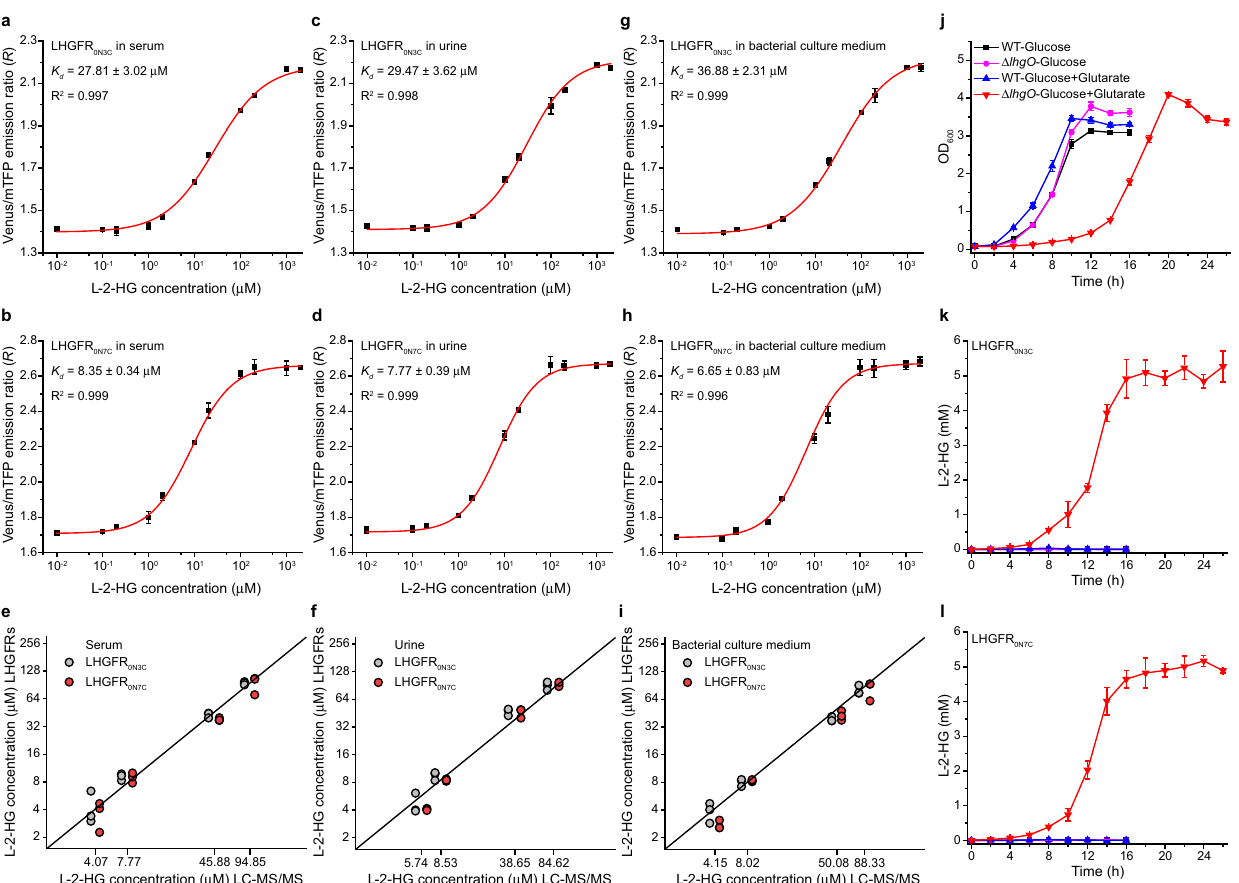
Fig. 4 Validation of puri fi ed LHGFR for determination L -2-HG levels in body fl uids and bacterial culture system. a – d Dose-response curves of puri fi ed LHGFR 0N3C and LHGFR 0N7C for increasing concentrations (10 nM to 2 mM) of L -2-HG in serum ( a, b ) and urine ( c , d ). e , f Comparison between the quantitative results of L -2-HG added in serum ( e ) and urine ( f ) by LC-MS/MS and LHGFR. The gray circles and red circles represent the quantitative results of LHGFR 0N3C and LHGFR 0N7C , respectively. Black line indicates a reference line. g, h Dose-response curves of puri fi ed LHGFR 0N3C ( g ) and LHGFR 0N7C ( h ) for increasing concentrations (10 nM to 2 mM) of L -2-HG in bacterial culture medium. i Comparison between the quantitative results of L - 2-HG in bacterial culture medium by LC-MS/MS and LHGFR. j Growth of P. putida KT2440 and its lhgO mutant in medium containing 20 mM glucose and 5 mM glutarate as the carbon sources. k , l Determination of extracellular L -2-HG accumulation of P. putida KT2440 and its lhgO mutant by puri fi ed LHGFR 0N3C ( k ) and LHGFR 0N7C ( l ). All data shown are means ± s.d. ( n = 3 independent